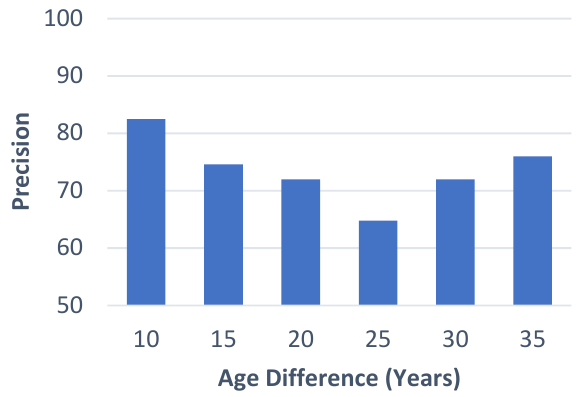
Figure 6. Effect of age difference in case retrieval on severity prediction performance.